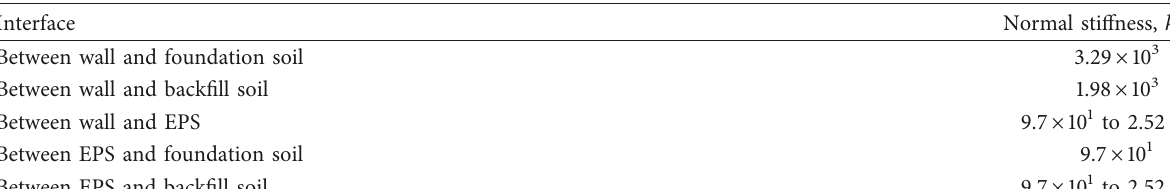
Table 7: Normal interface stiffness for the 9m high wall.